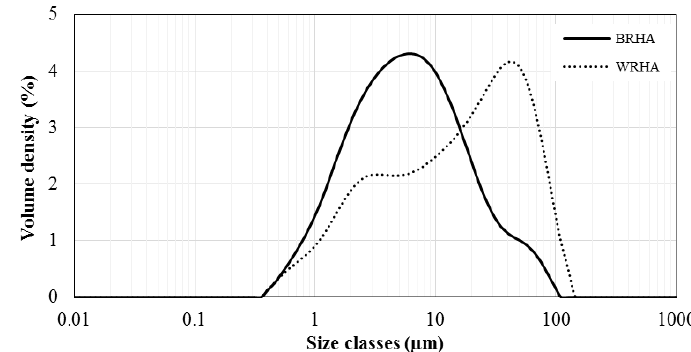
Figure 3. Particle size distributions of BRHA and WRHA particles.